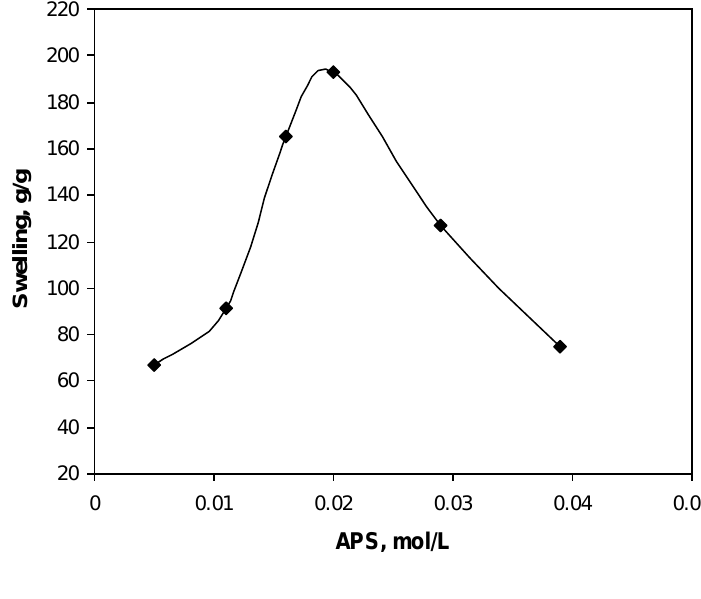
Figure 2. Effect of initiator concentration on swelling